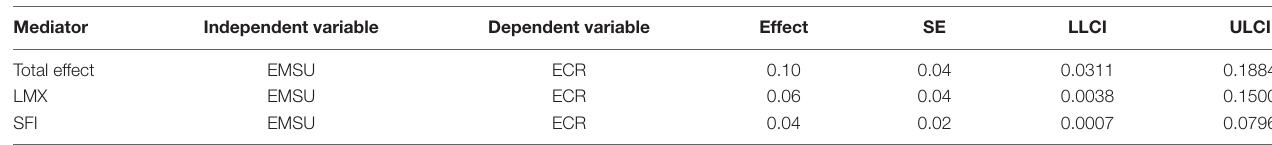
TABLE 2 | Indirect effect of enterprise social media usage on employee creativity via LMX and SFI.